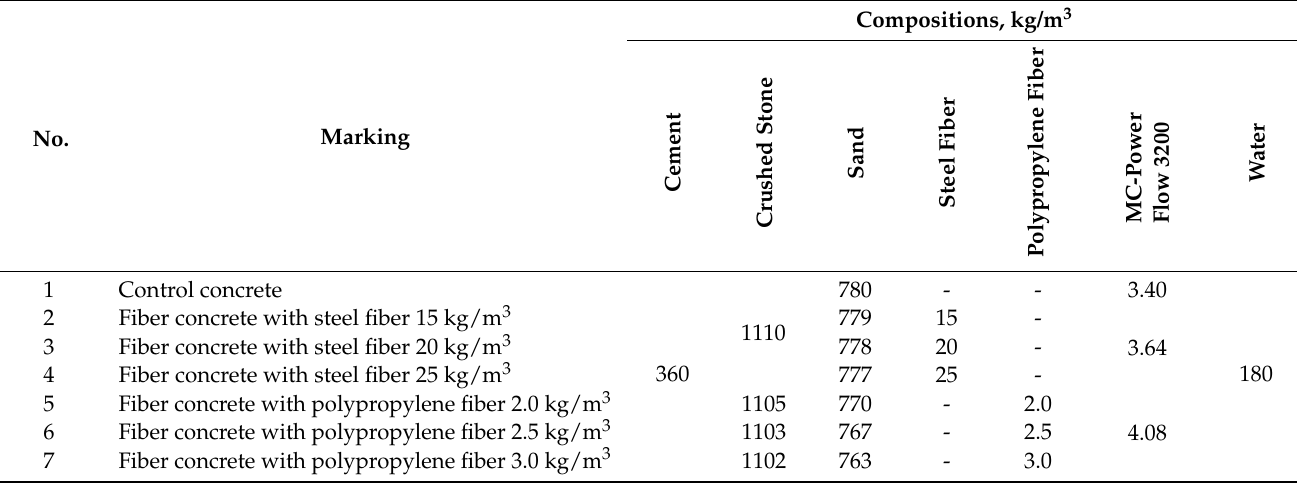
Table 1. Compositions of the studied concrete and fiber concrete.